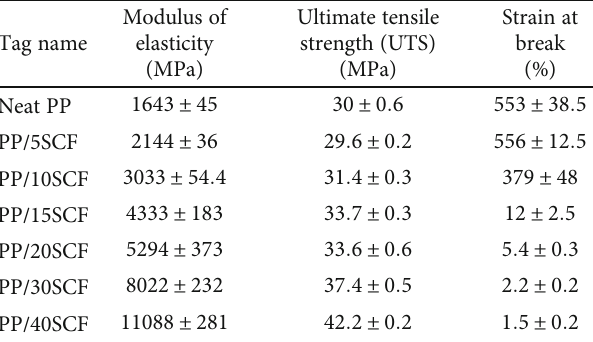
Figure 2: Representative stress-strain diagram of PP/SCF composites with 0 – 40 wt% of SCF. Table 4: Mechanical properties of neat PP and its composites with 0 – 40 wt% of